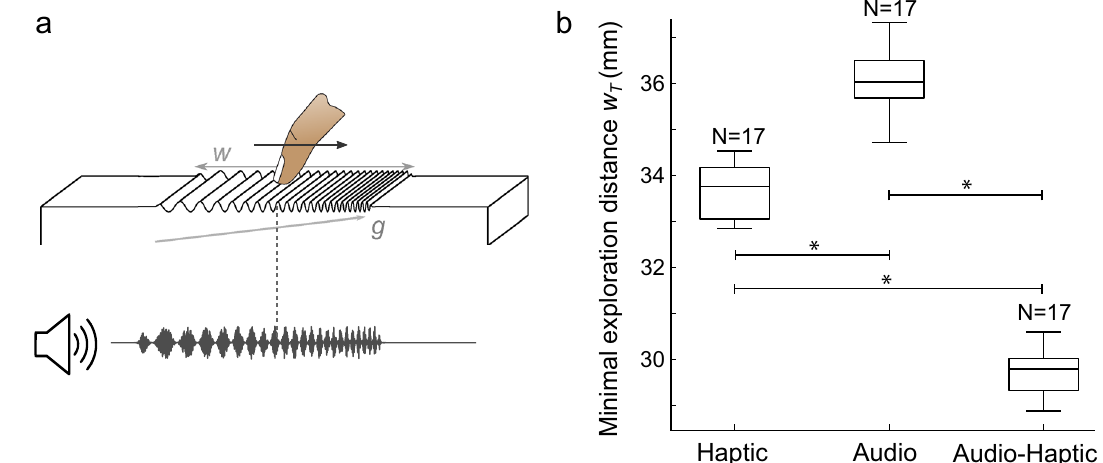
Figure 4. Audio-haptic interaction. ( a ) Illustration of the multimodal experiment with audio feedback derived from the haptic texture. ( b ) Perception threshold for the unimodal and multimodal conditions. The thresholds are represented by the minimal exploration distance to perceive a difference in frequency with the gradient value g = 0.025 mm − 1